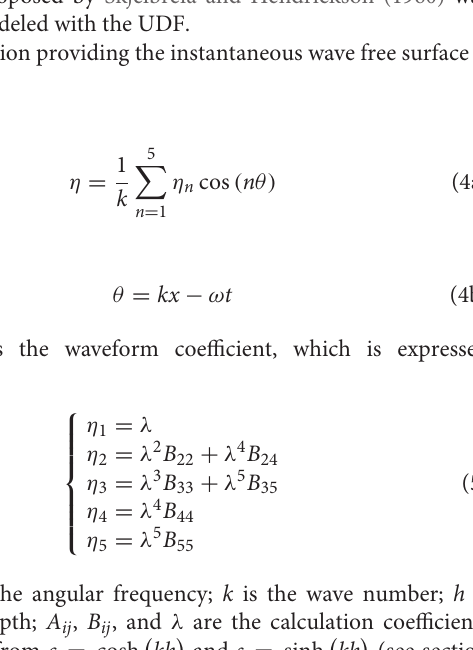
to low-order non-linear wave theory, high-order wave theory is more accurate (Zhu, 1983). Therefore, the fifth-order Stokes wave theory as proposed by Skjelbreia and Hendrickson (1960) was used and modeled with the